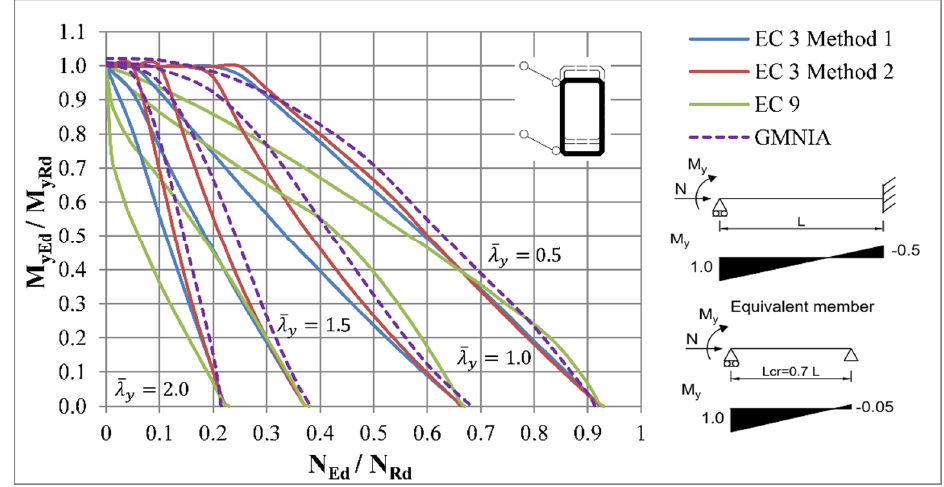
Figure 33. Interaction curves for laterally restrained beam-columns with RHS cross-section.